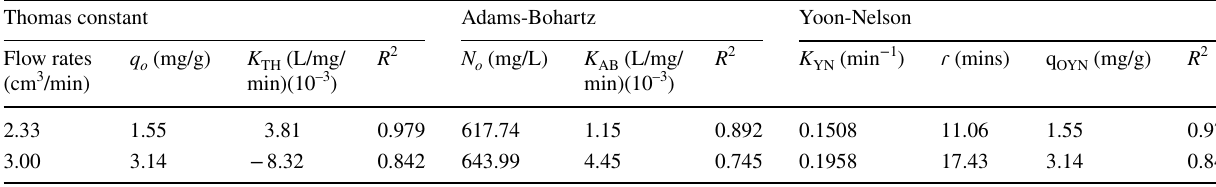
Table 4 Effect of flowrate on adsorption model constants Thomas